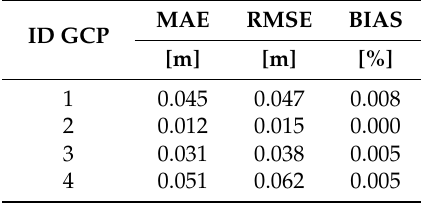
Table 1. Mean absolute error (MAE) between observed and estimated values, the root mean squared error (RMSE) and the BIAS in percentage are reported for each ground control point (GCP). MAE RMSE BIAS ID GCP [m] [m] [%]